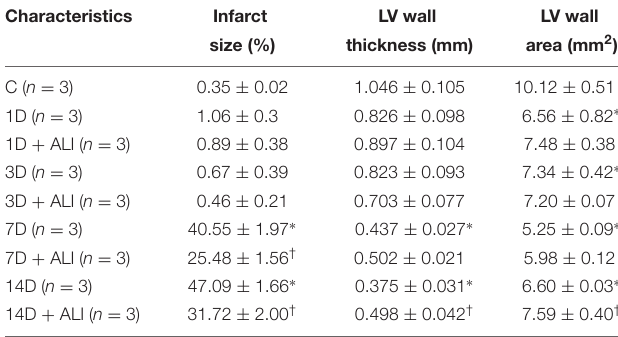
TABLE 2 | Left ventricular (LV) classification of heart